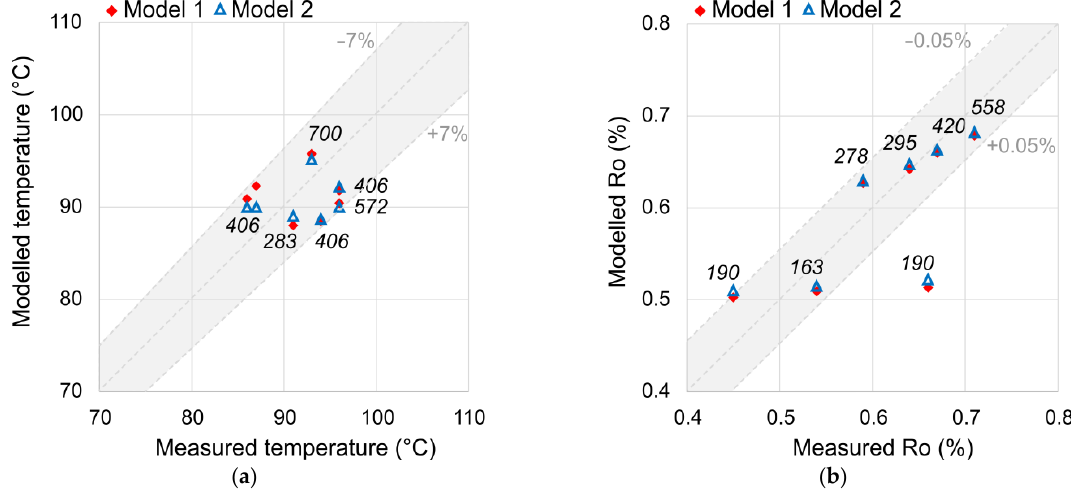
Figure 5. Calibration results of present-day measured and modelled ( a ) temperatures and ( b ) vitrinite reflectance by the EasyRo kinetic model [73]. Italic numbers near the data points correspond to the wellbore location (in km) along the profile. Grey zones show the area of ±7% for temperature and ±0.05% (absolute) for vitrinite reflectance. The final geological section is presented in Model 1 in in Figure 6a.